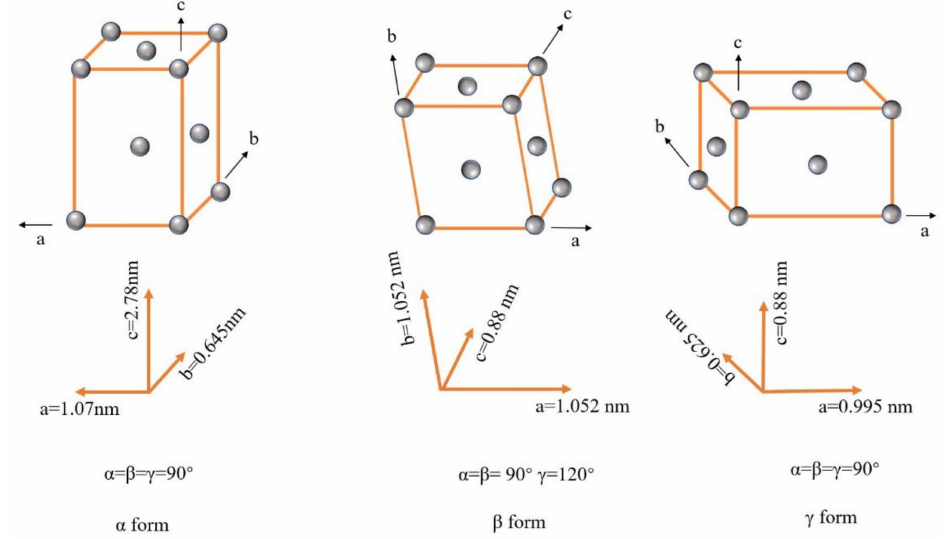
Figure 2. Crystal form model of